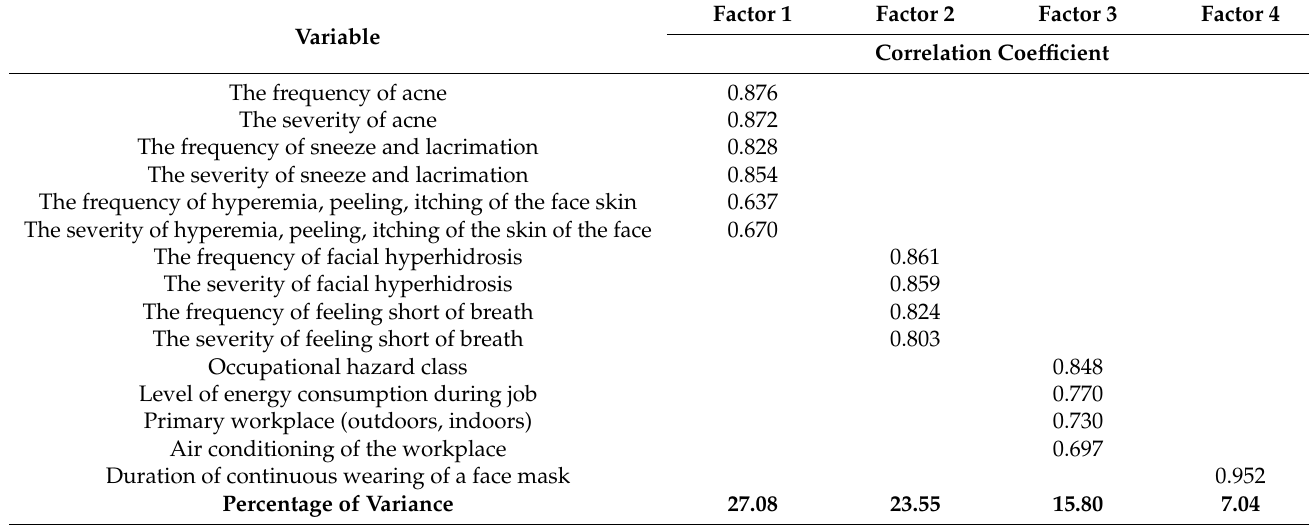
Table 6. A subjective assessment of adverse reactions to and discomfort toward wearing a face